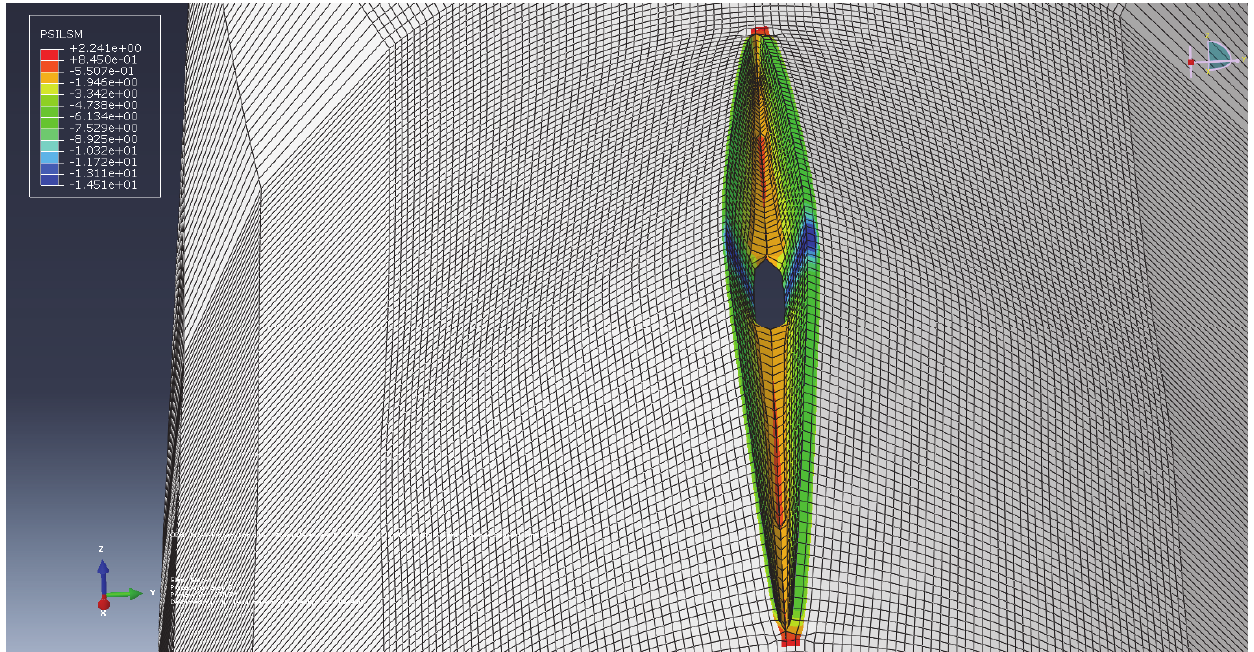
Figure 8: The 7 th step – crack became through-wall and stresses around the